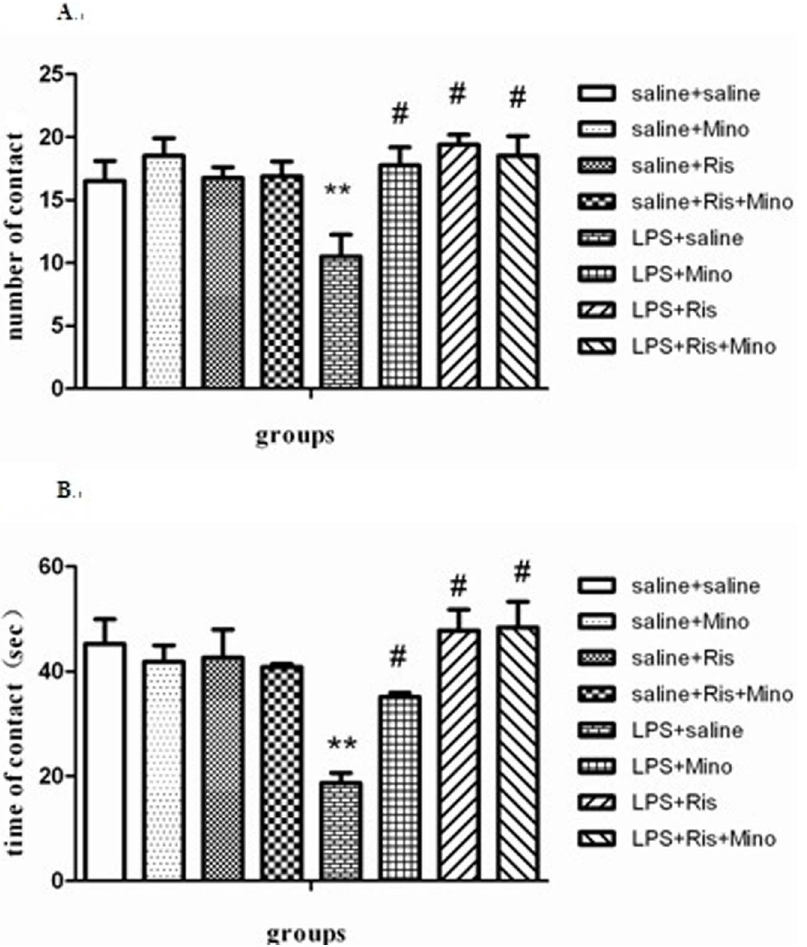
Figure 3. Effects of minocycline, risperidone and combination of these two on LPS-induced social interaction behaviors shown by number of contact (Figure 3A) and time spent in contact (Figure 3B). The data are shown as means 6 SEM. n = 8 for each group. ** P , 0.01, compared with saline-injected group; # P , 0.01, compared with LPS-injected group.